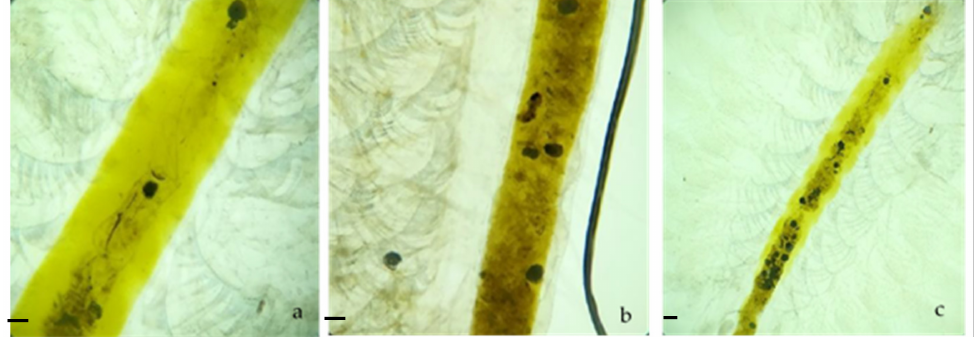
Figure 2. Artemia salina after 48 h of exposure to different MP concentrations: ( a ) 26 mg/dm 3 of MPs, ( b ) 0.69 mg/dm 3 of MPs and ( c ) 1.5 mg/dm 3 of MPs. Scale bar ( a – c ): 200 µ m.